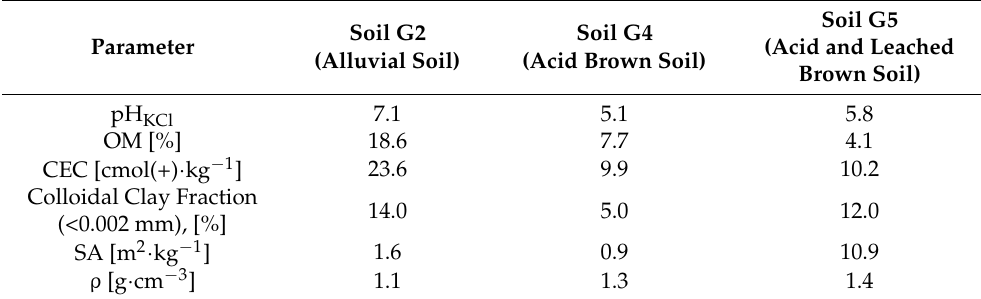
Table 4. Properties of soils used in this